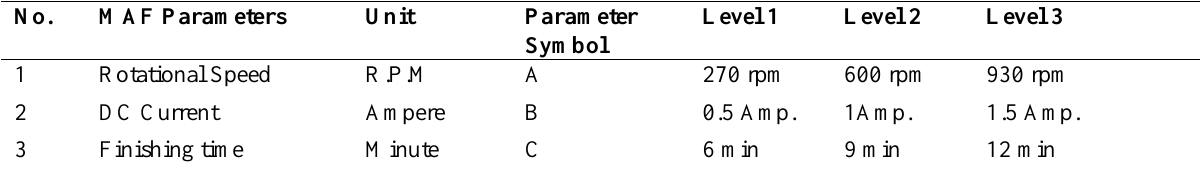
Selected MAF Parameters and corresponding levels No.